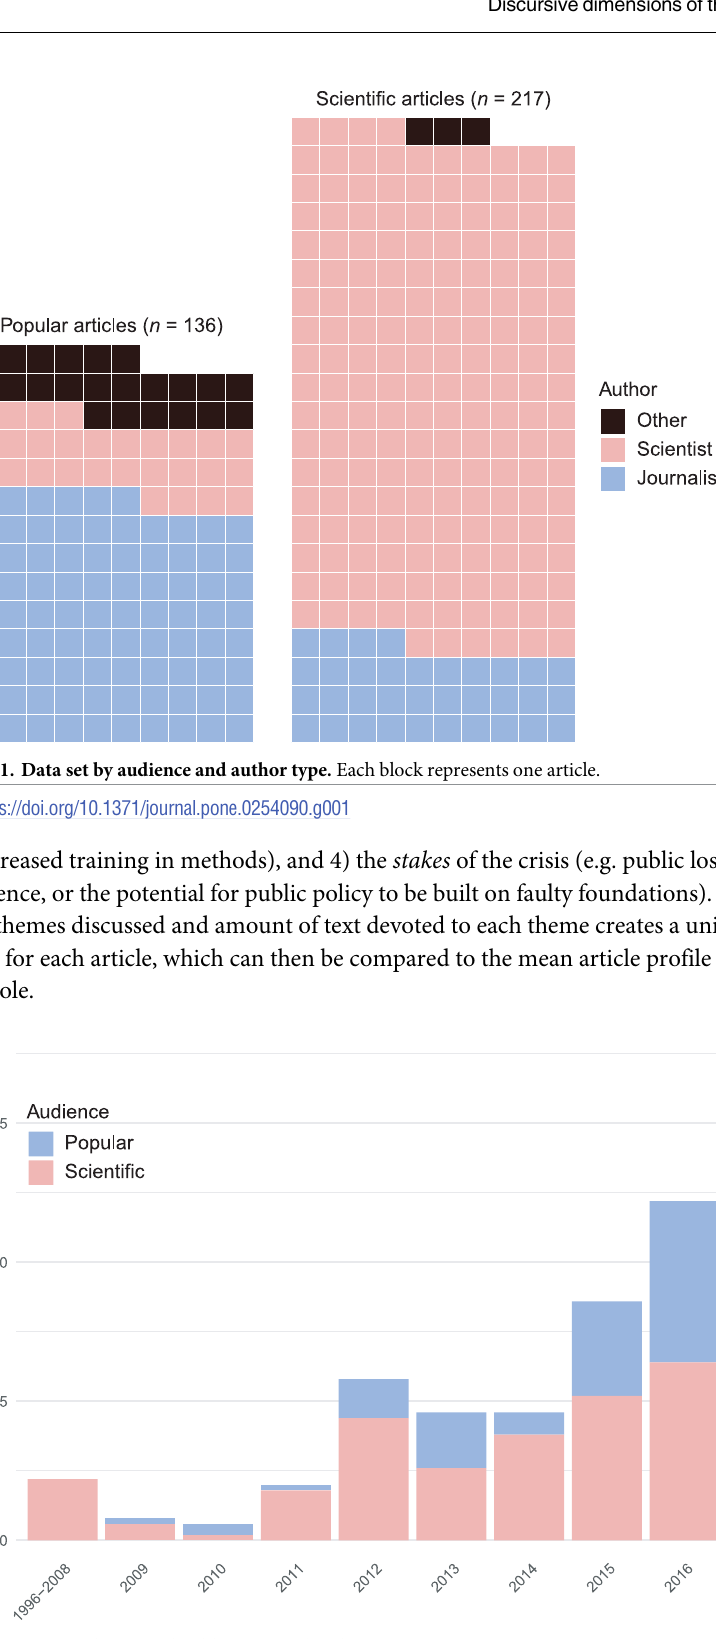
Fig 2. Data set by year of publication and